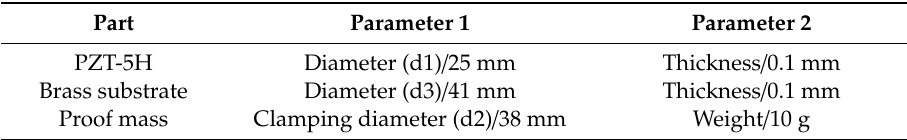
Figure 2. Photograph ( a ) and structural parameters ( b ) of the piezoelectric circular diaphragm (PCD) energy harvester. Table 1. Size parameters of the PCD energy harvester’s each part.